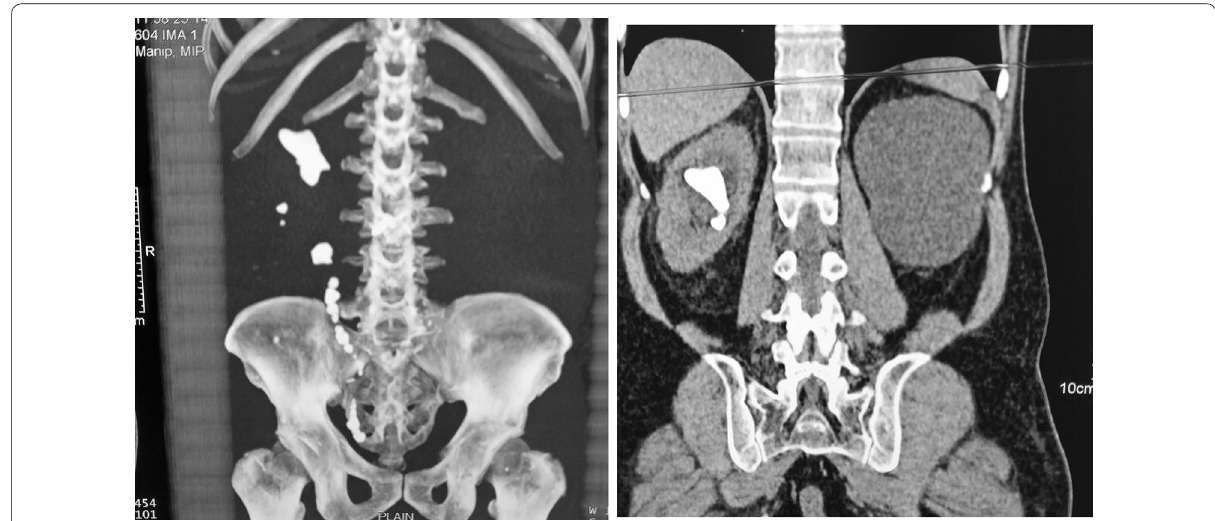
Fig. 1 CT KUB image of the patient posted for procedure